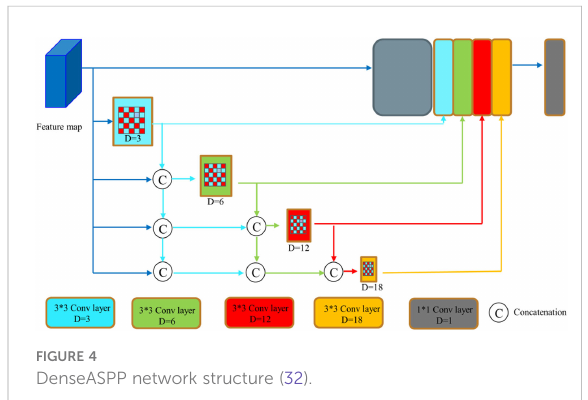
FIGURE 4 DenseASPP network structure